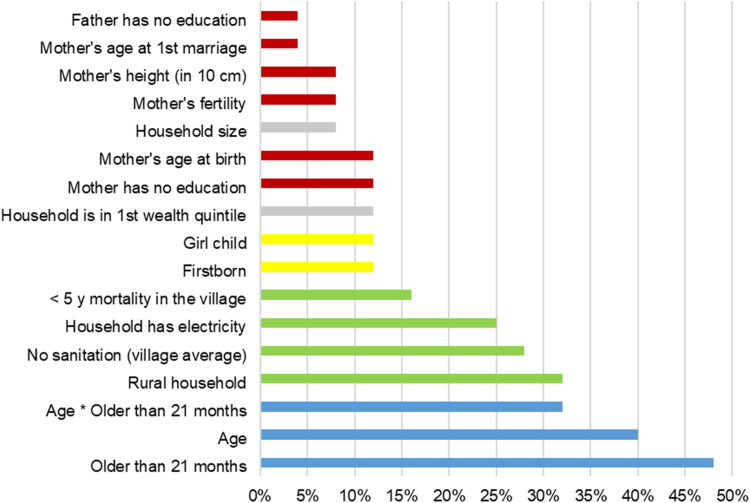
Temporal stability of covariates in Demographic and Health Surveys in 25 countries. Legend: Data reported as % countries in which the coefficient associated with the covariate was significantly unstable between the first and last survey as indicated by Wald test (5% significance level). Variable groups: parental (red), household (grey), and child (yellow) characteristics had stable associations with HAZ over time, but community and infrastructure variables (green) were more unstable; variables modeling cross-sectional growth faltering (blue) were the most unstable.